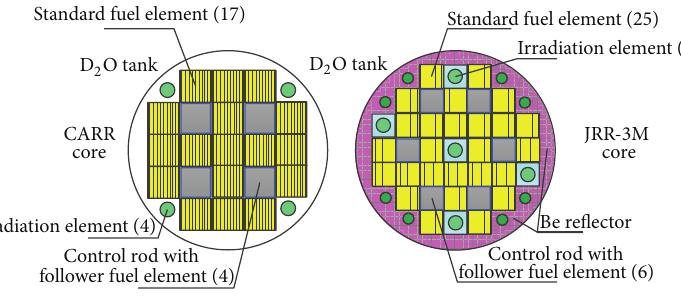
Figure 1: Cross-section view of CARR [4] and JRR-3M [2, 3].